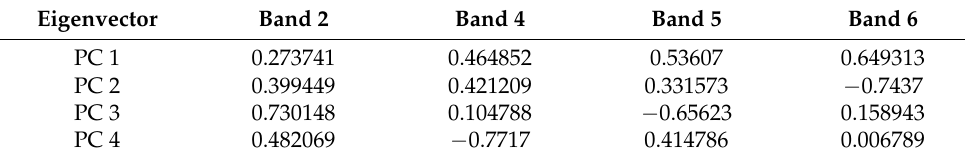
Table 8. Eigenvector loading for PC bands 2, 4, 5, and 6.